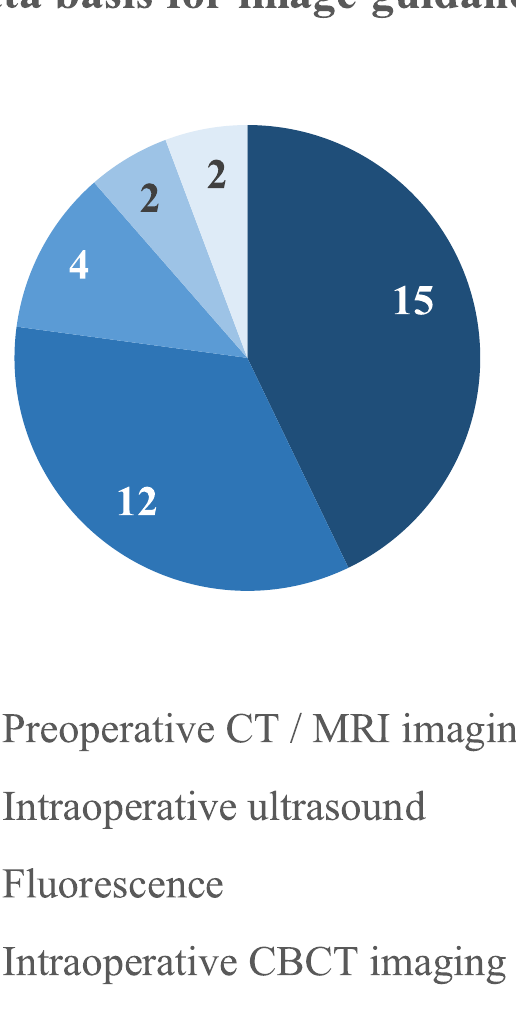
Fig 3. Data basis for software assistance approaches reported in literature. The overall number reported is 30 because one publication [28] uses both intraoperative ultrasound data and preoperative imaging data. CBCT: Cone beam